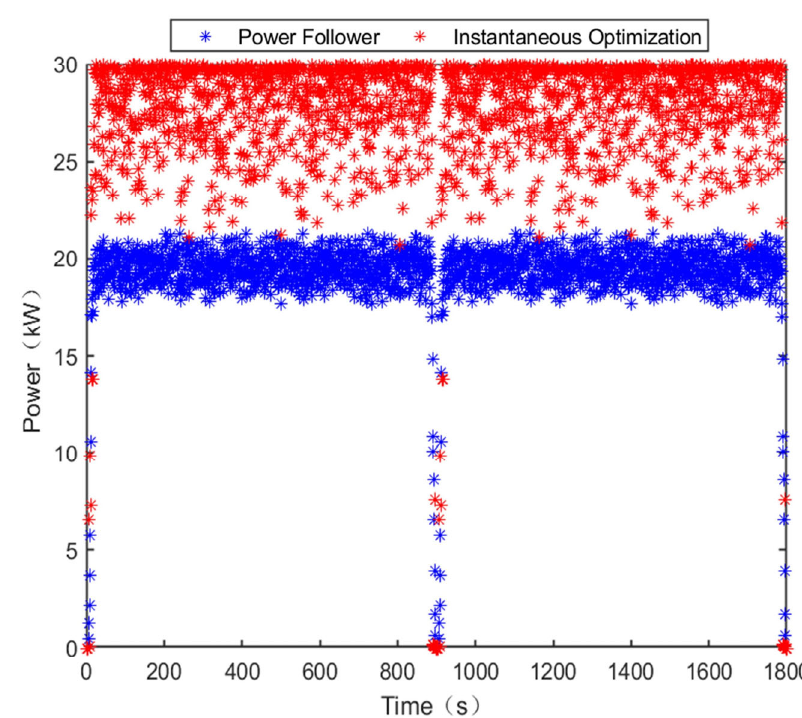
Figure 11. Working power of motor.